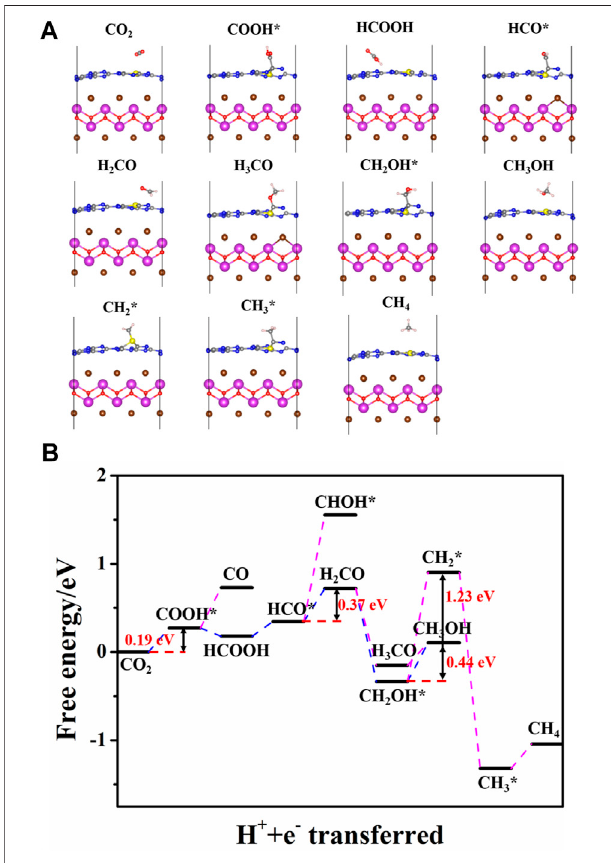
FIGURE 10 | (A) Optimized structure of reaction intermediates and (B) free energy diagram on the optimal path of CO 2 reduction on BiOBr/S-g- C 3 N 4